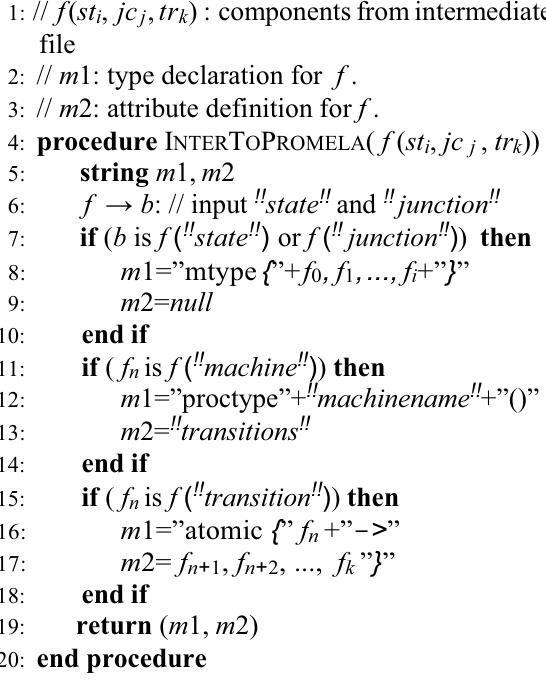
Fig. 7. Intermediate file to P